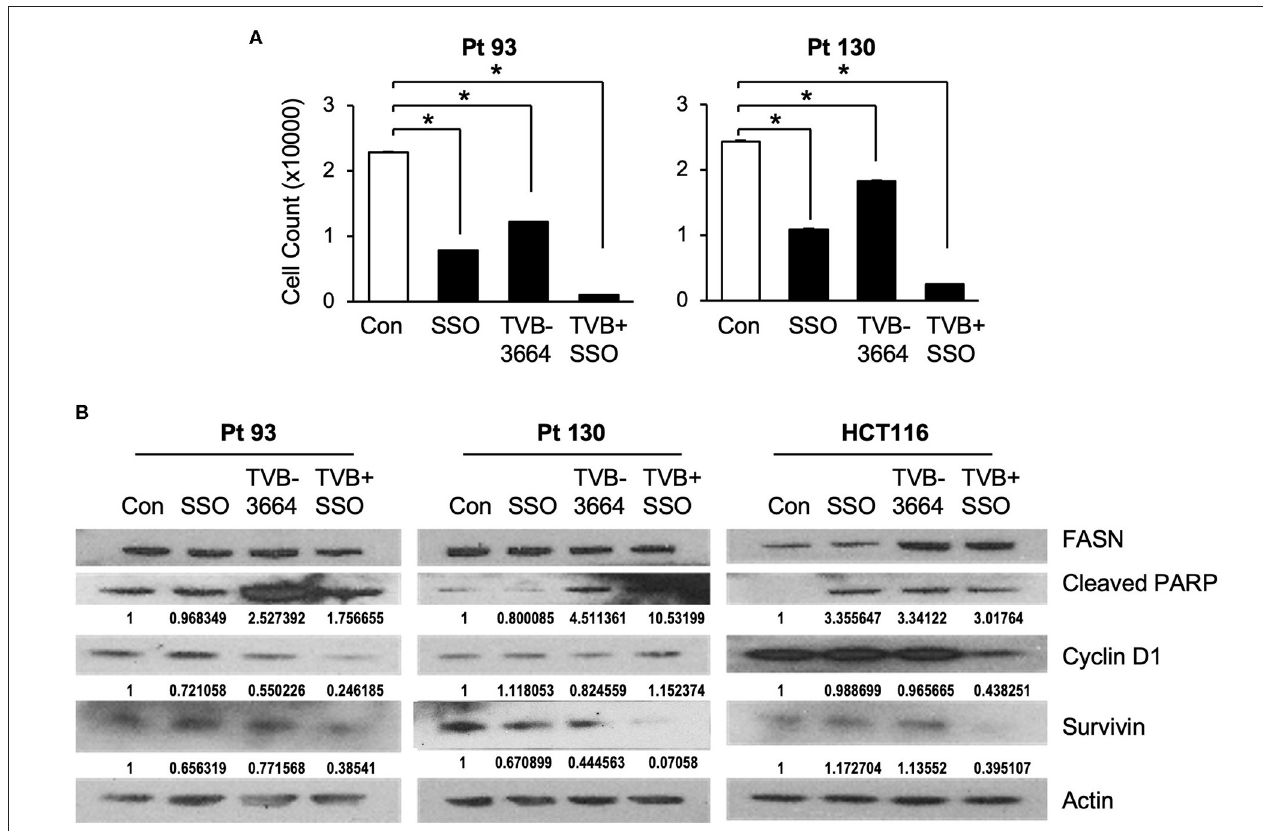
FIGURE 6 | Inhibition of CD36 and FASN have a synergetic effect in reducing cell proliferation. (A) Pt 93, Pt 130, and HCT116 cells were treated with SSO and TVB-3664 alone or in combination for 6 days and cell number was counted. Representative data from three experiments is shown (* p < 0.05). (B) Western blot analysis of cells treated with TVB-3664, SSO, or TVB-3664 and SSO in